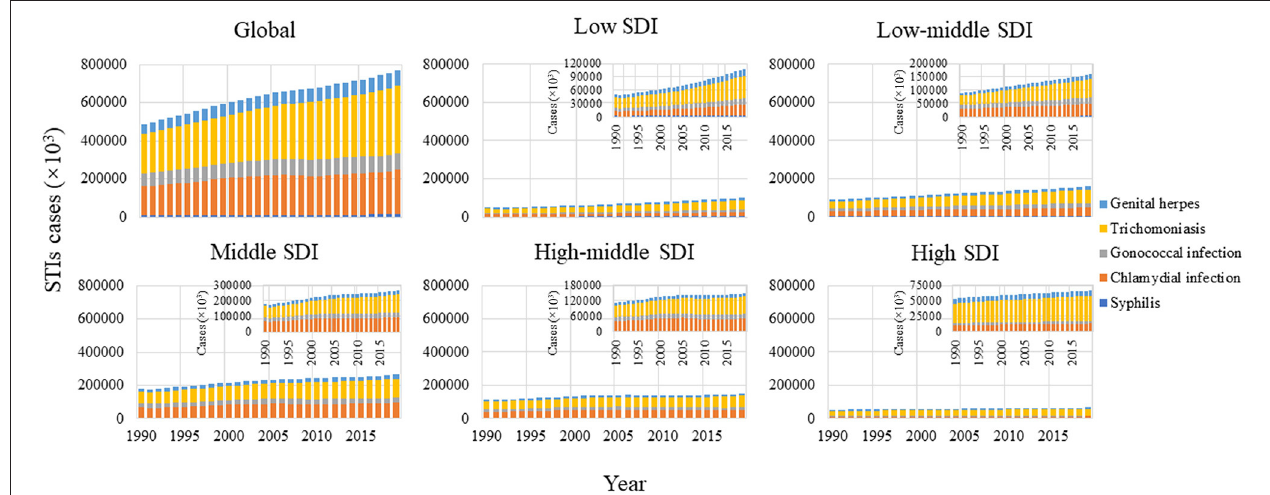
FIGURE 3 | Number of incident cases of STIs excluding HIV 1990-2019, stratified by SDI region. SDI regions with lower number of cases are magnified in the top- right of the panel SDI, sociodemographic index; STIs, sexually transmitted infections; HIV, human immunodeficiency virus.